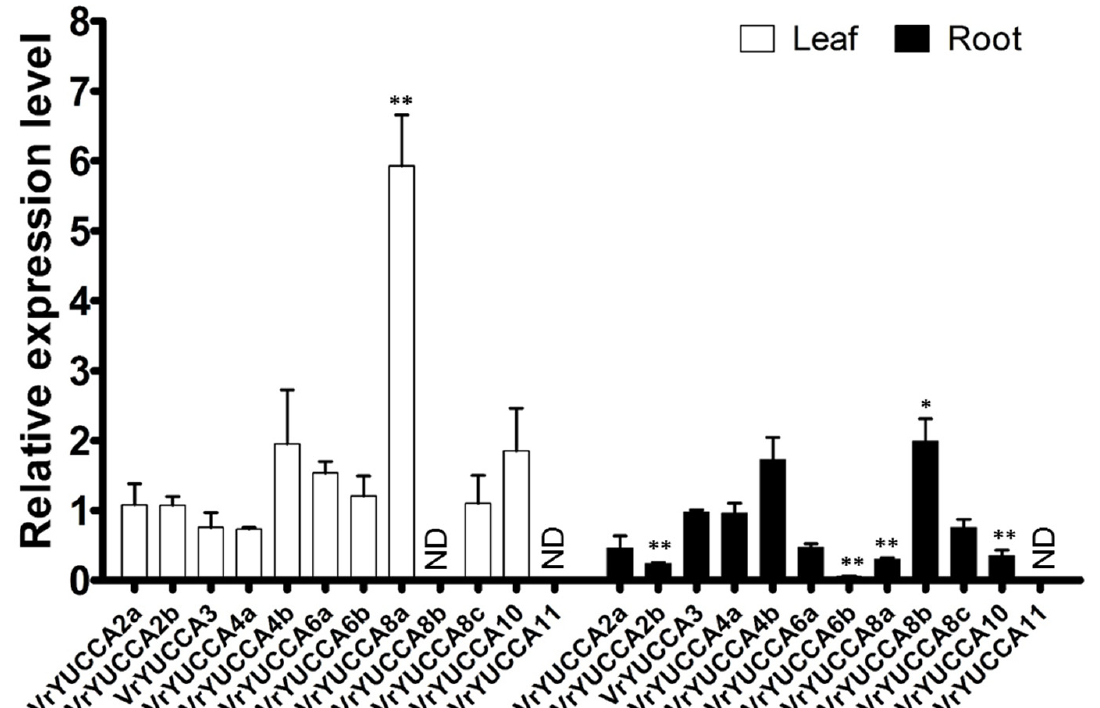
Figure 6. Effect of IAA on the expression of VrYUCCAs . The asterisks indicate statistical signifi- cance (*, p < 0.05; **, p < 0.01) compared with each CK (standardized as 1). Error bars indicate SDs from 3 biological repetitions. ND: not detectable.